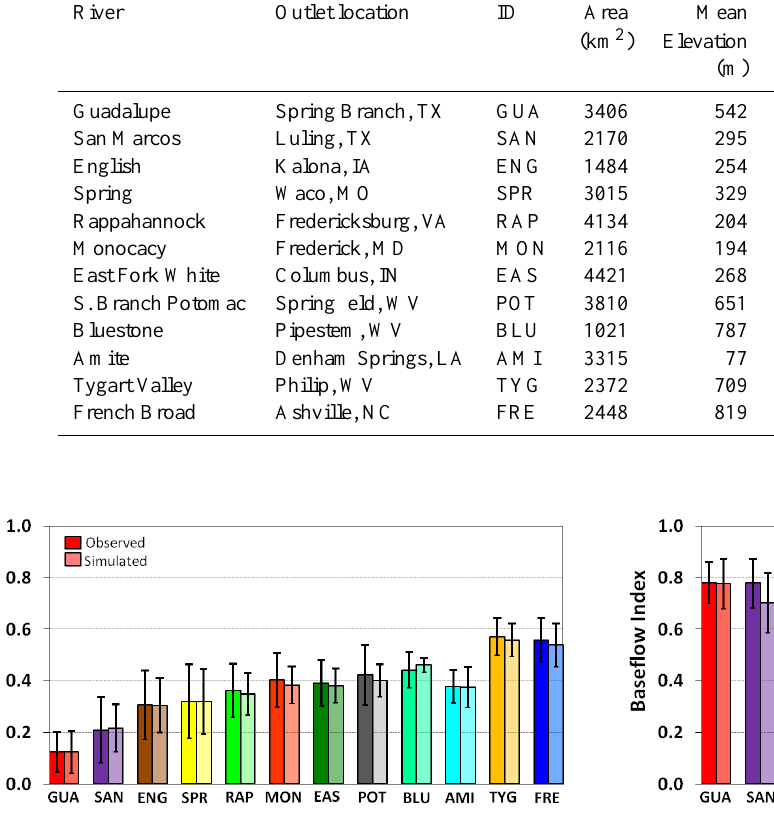
Figure 4 : Observed versus simulated runoff coefficients for all 12 catchments for the period 1990- Fig. 4. Observed versus simulated runoff coefficients for all 12 Fig. 5. Observed versus simulated baseflow indices for all 12 catch- 1999. The error bars represent ± one standard deviation of the observed and modeled annual Figure 5 : Observed versus simulated baseflow indices for all 12 catchments for the period 1990- catchments for the period 1990–1999. The error bars represent ± 1 ments for the period 1990–1999. The error bars represent ± 1 stan- runoff coefficients, respectively. 1999. The error bars represent ± one standard deviation of the observed and modeled annual baseflow indices, respectively. standard deviation of the observed and modeled annual runoff coef- dard deviation of the observed and modeled annual baseflow in- ficients, respectively. dices,